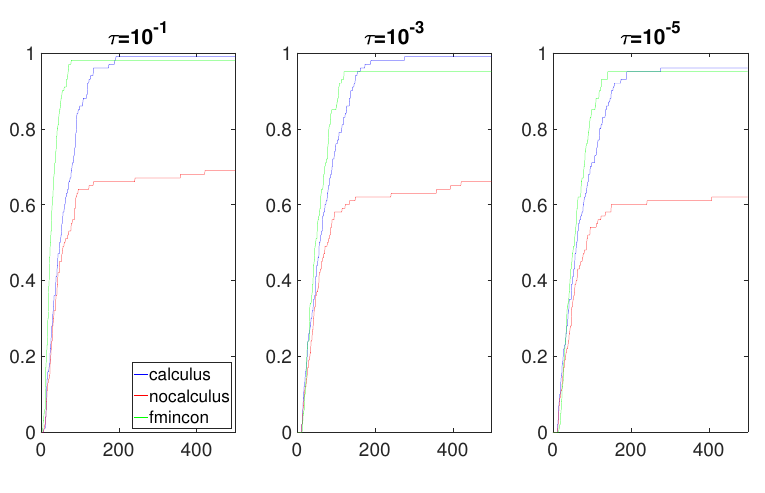
, f 1 is a quadratic function, and f 2 is a linear function. f 2